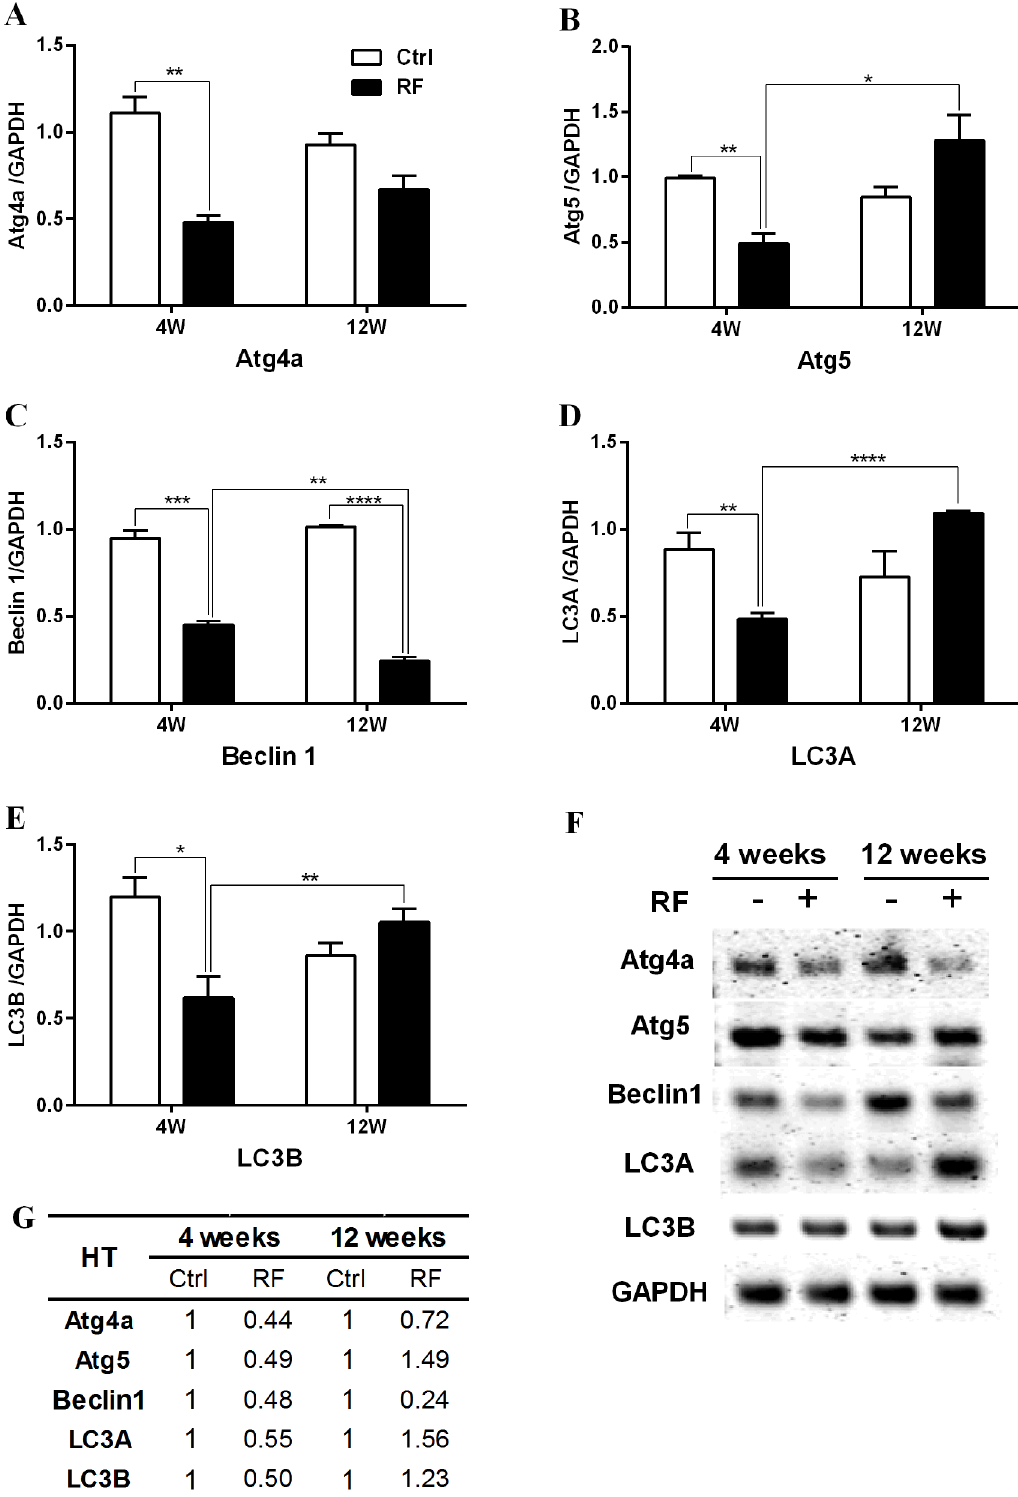
Fig 2. Expression of autophagy genes in the hypothalamus of mice following 835MHz RF exposure. Hypothalamic RNA extracted from control and RF-exposed mice were analysed for the expression of autophagy genes by semiquantitative RT-PCR and quantitative RT-PCR. (A-E) Quantification of Atg4a, Atg5, Beclin1, LC3A and LC3B mRNA by qRT-PCR and (F) expression level of autophagy genes by sqRT-PCR. The expression values of the